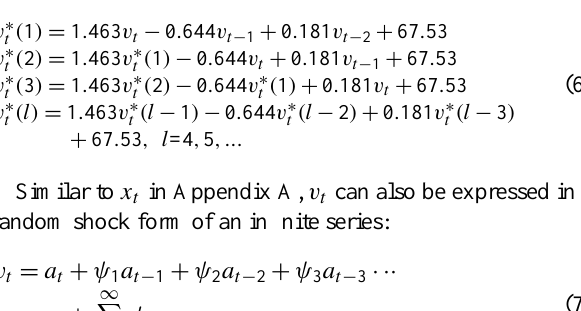
Fig. 7. Dam-break probability as a discrete time series at an interval of one day in stage 1